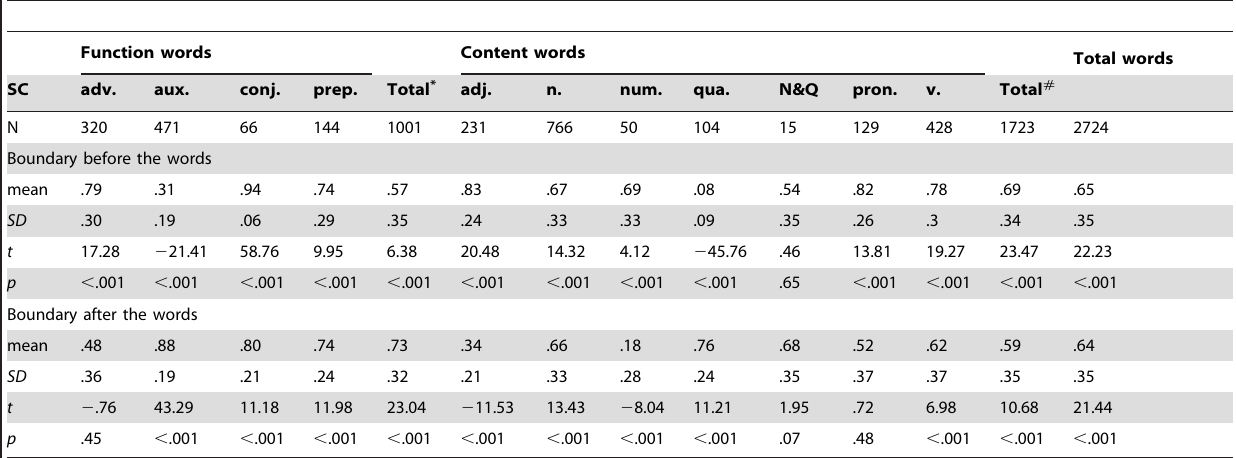
Table 1. Single Sample t-test Analyses and Agreement Proportion for Word Boundary Before and After the Various Words